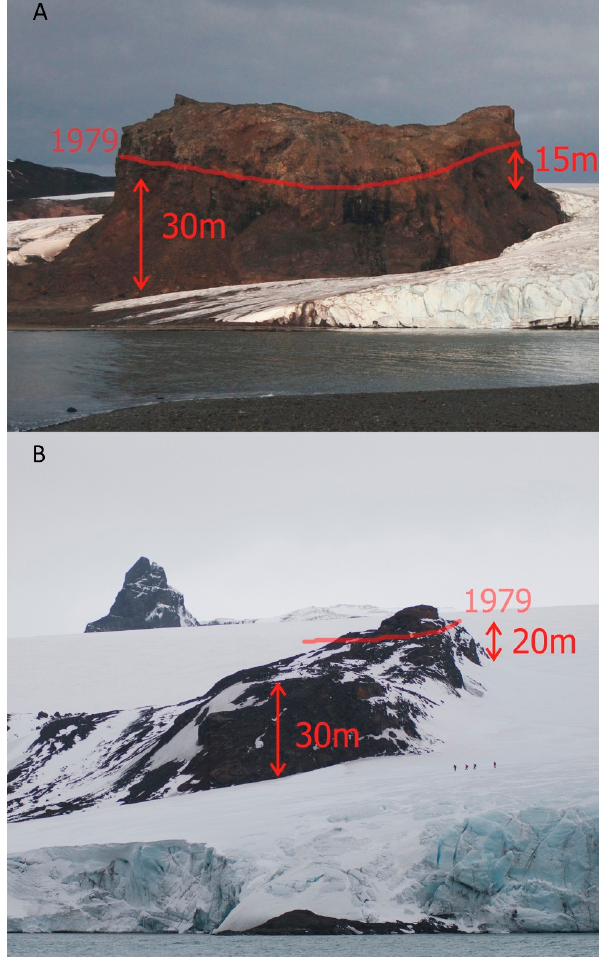
Figure A5. Changes in ice thickness highlighted on former nunataks: Siod ł o (A) and Tarnica (B).